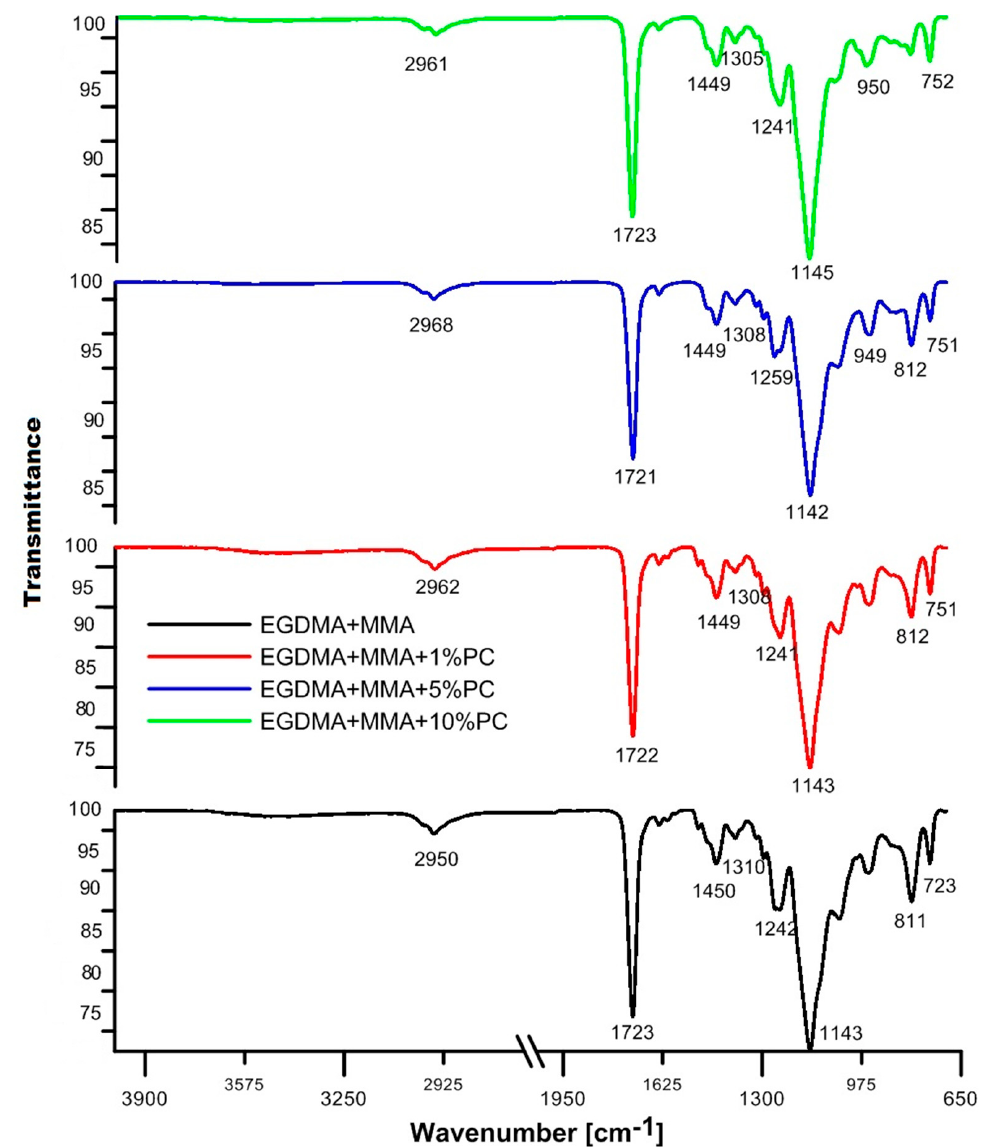
Figure 4. ATR/FT-IR spectra of EGDMA + MMA derived blends.